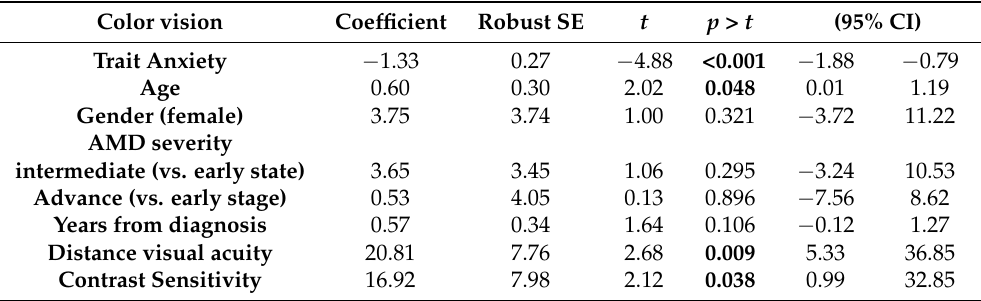
Table 9. Robust multiple linear regression model that correlates trait anxiety with the subscale Color vision from the quality-of-life questionnaire